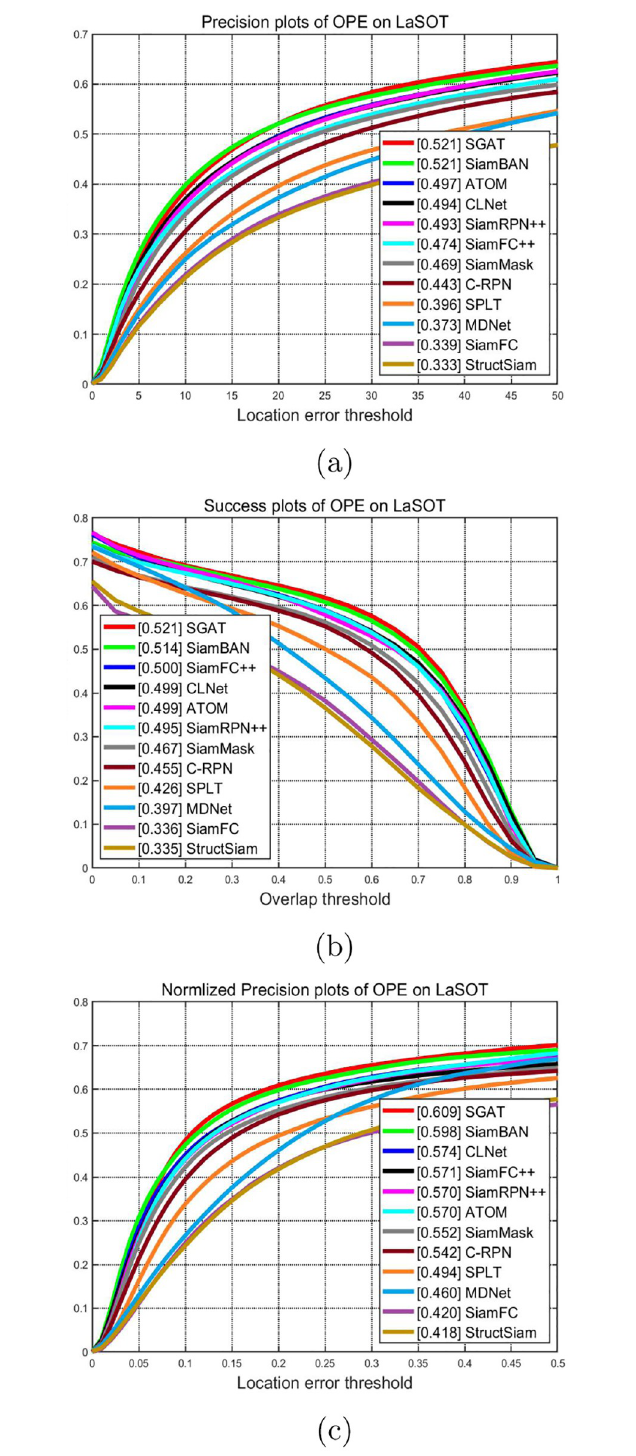
Fig 6. Comparision with state-of-the-art trackers on LaSOT in terms of the precision rate, success rate and normalized precision plots.